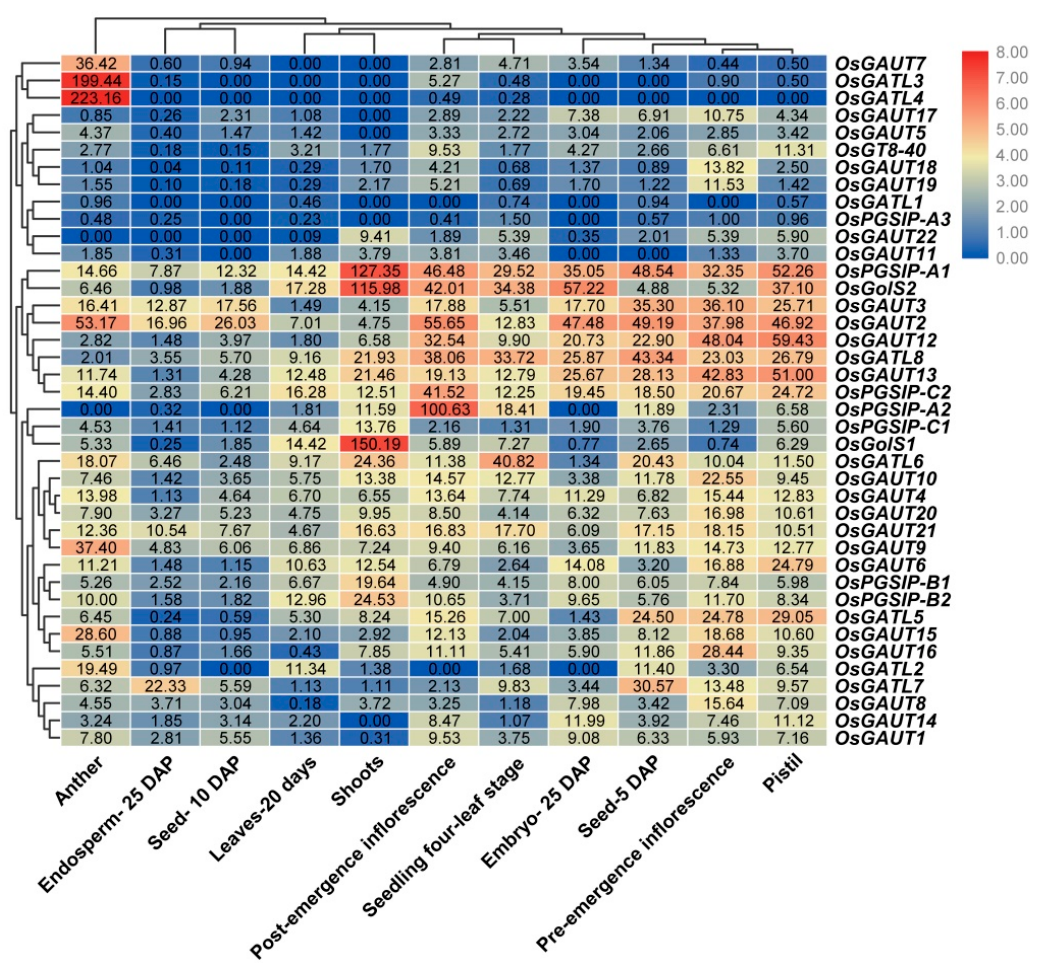
Figure 5. Expression profiles of OsGT8 genes in different tissues. The values in the color scale represent log 2FPKM : red/blue indicates high level/low level of transcript abundance.